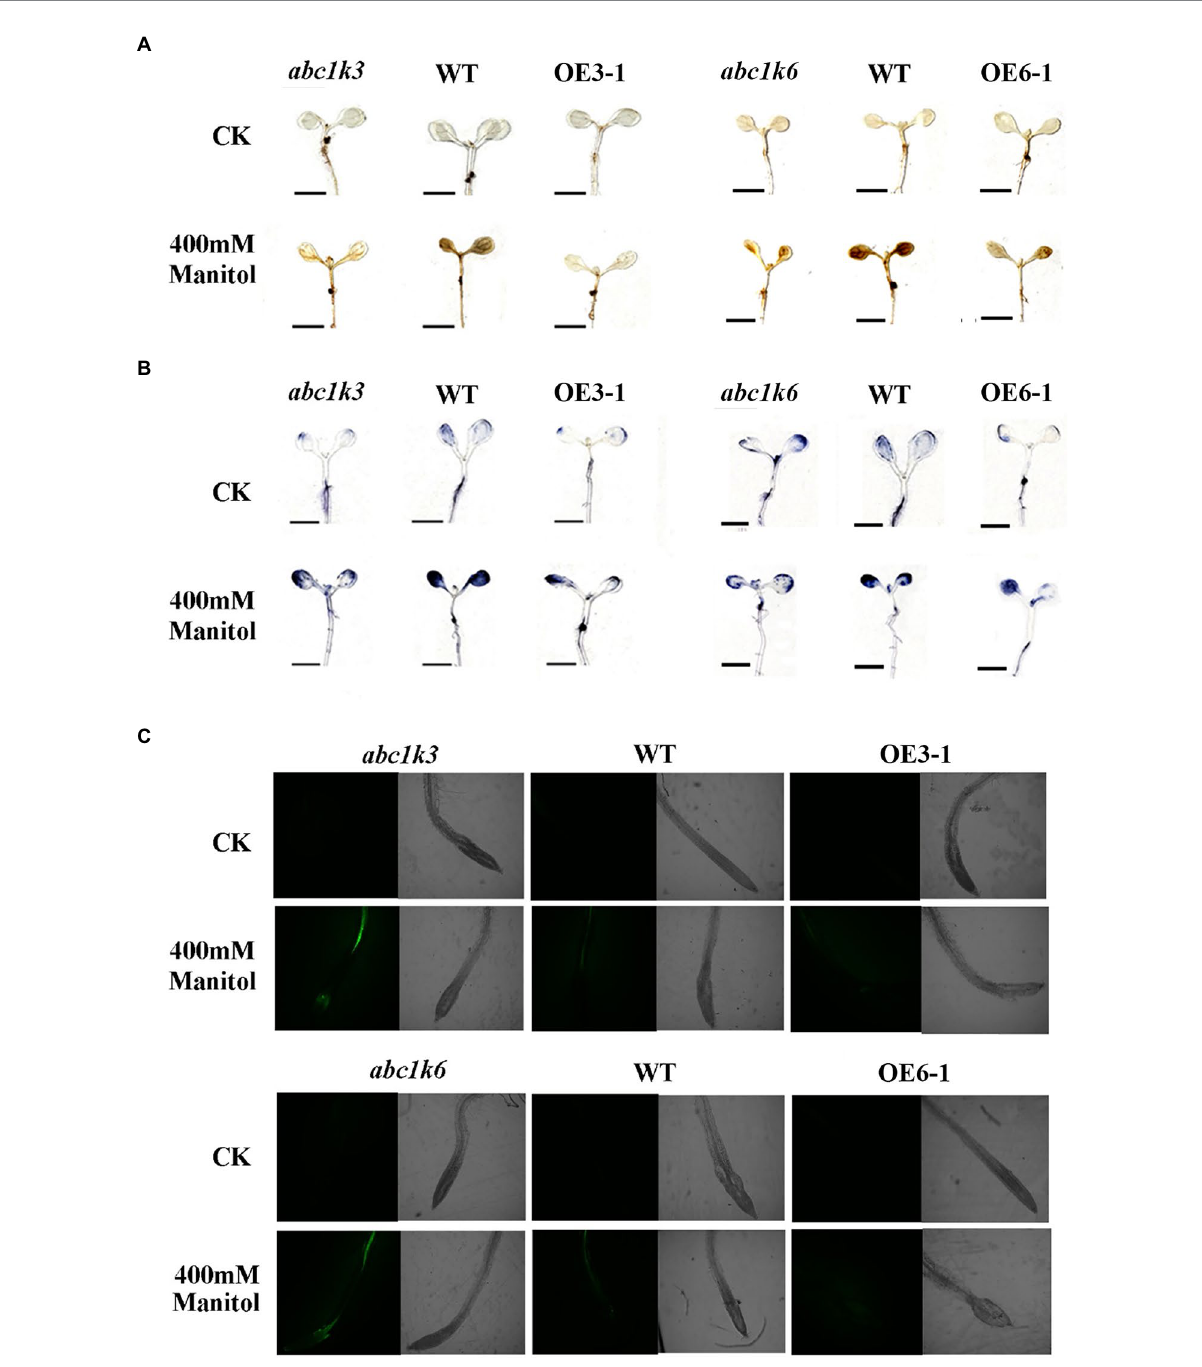
FIGURE 9 Overexpression of TaABC1K3 and TaABC1K6 suppressed the active oxygen burst triggered by drought stress in Arabidopsis mutant abc1k3 and abc1k 6 . (A,B) Differences of ROS content in abc1k3/6 mutant, wild-type and TaABC1K3/6 overexpressed plants under 400 mM mannitol stress. The seedlings were stained by diaminobenzidine (DAB; A ) to form brown precipitates in the presence of hydrogen peroxide, or by nitroblue tetrazolium staining (NBT; B ) to produce blue precipitate in the presence of superoxide (Scale bar =5 mm). (C) Seedlings of abc1k3/6 mutant, wild- type and TaABC1K3/6 overexpressed plants were subjected to DCFH-DA staining under 400 mM Mannitol